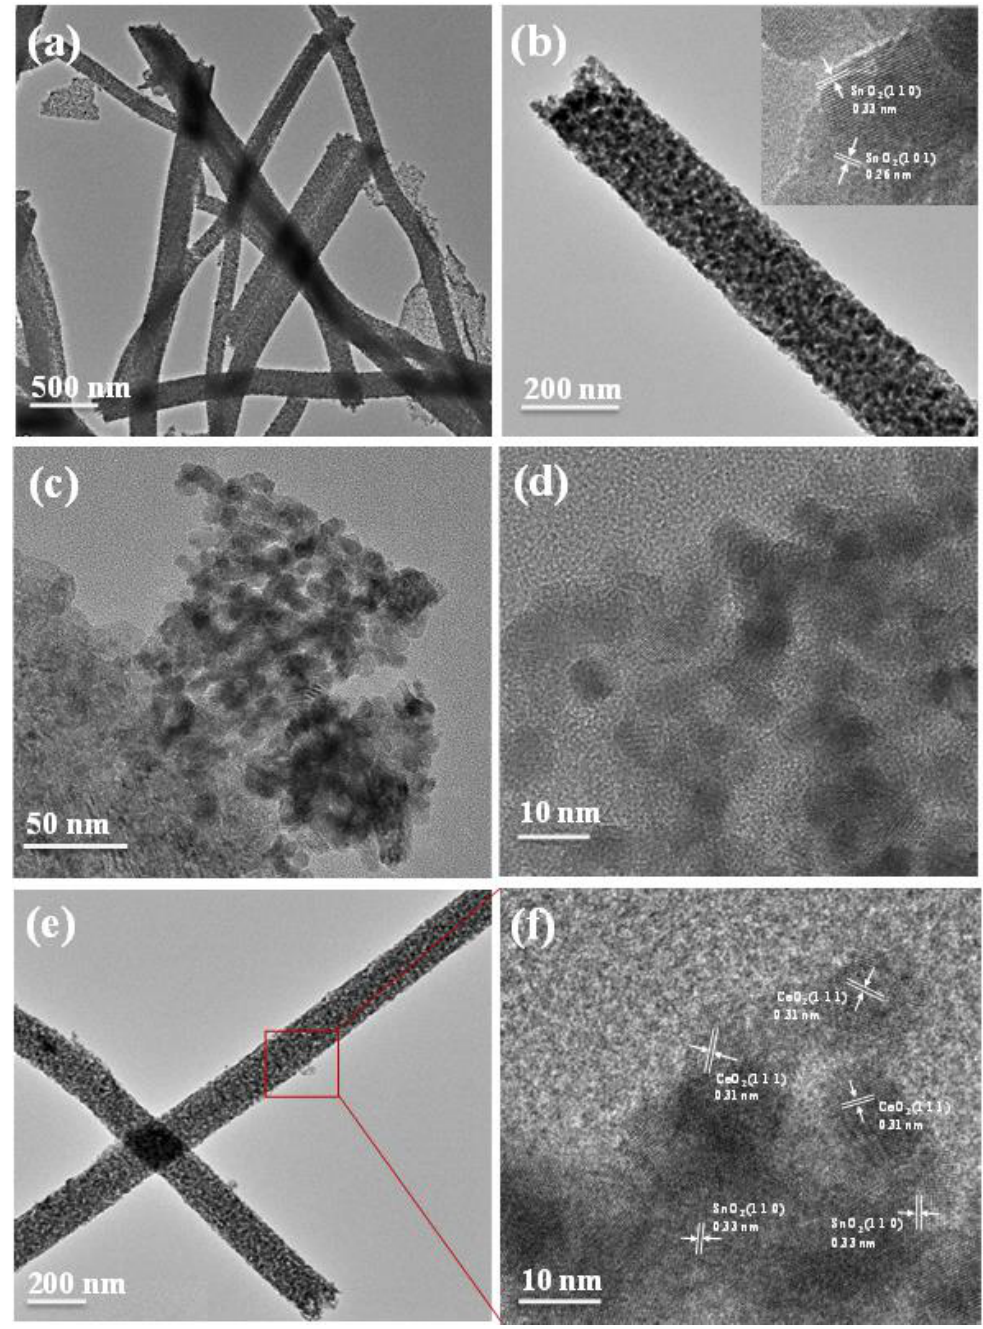
Figure 4. TEM micrographs of ( a,b ) SnO 2 , ( c , d ) CeO 2 , and ( e , f ) SnO 2 /CeO 2